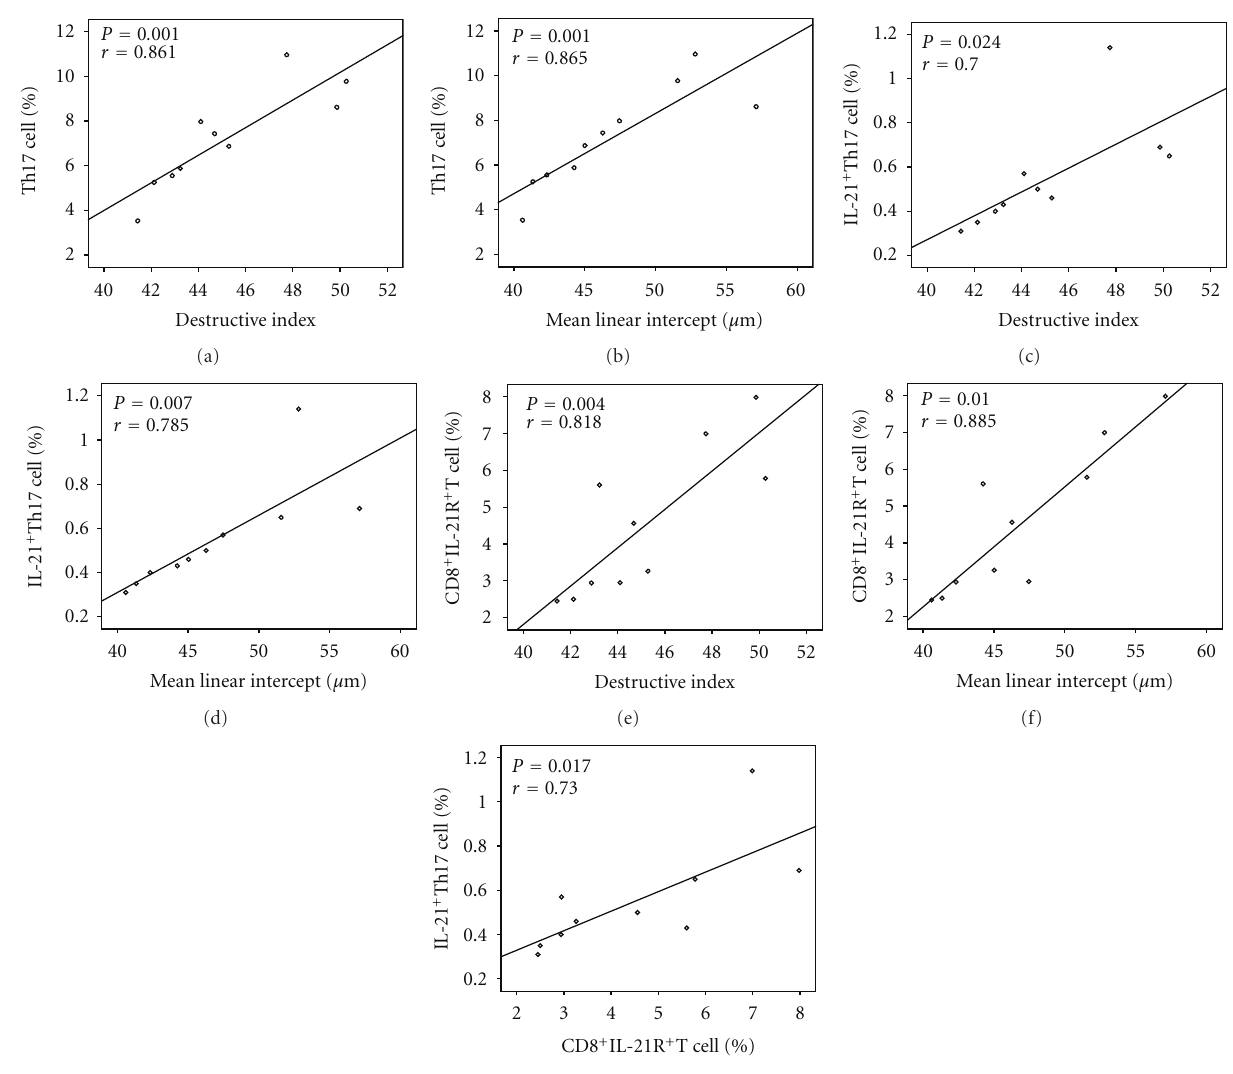
Figure 7: Correlations between (a) the frequency of CD4 + IL-17 + Th17 cells in lungs and DI, (b) the frequency of CD4 + IL-17 + Th17 cells in lungs and Lm, (c) the frequency of IL-21 + Th17 cells in lungs and DI, (d) the frequency of IL-21 + Th17 cells in lungs and Lm, (e) the frequency of CD8 + IL-21R + T cells in lungs and DI, (f) the frequency of CD8 + IL-21R + T cells in lungs and Lm, and (g) the frequency of CD8 + IL-21R + T cells and the frequency of IL-21 + Th17 cells in lungs. Data were determined by Pearson’s rank correlation coeficients.